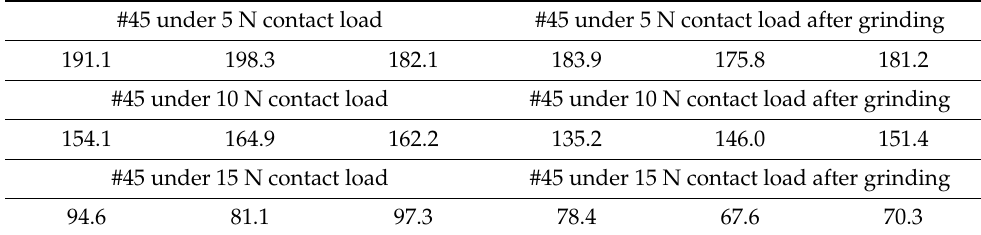
Table 2. Measured data of abrasive heights for #45 steels ( µ m).